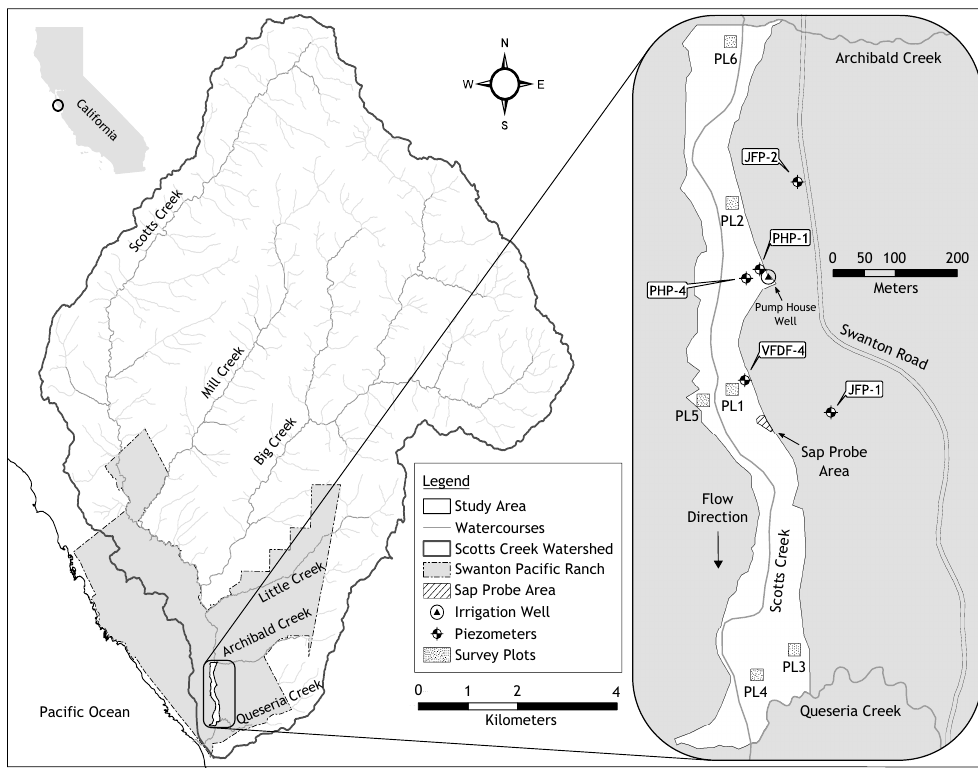
Figure 1. A map (adapted from [20]) of the Scotts Creek watershed, Swanton Pacific Ranch, and the riparian forest study area. The map shows the location of the instrumented phreatophytes, survey plots, and